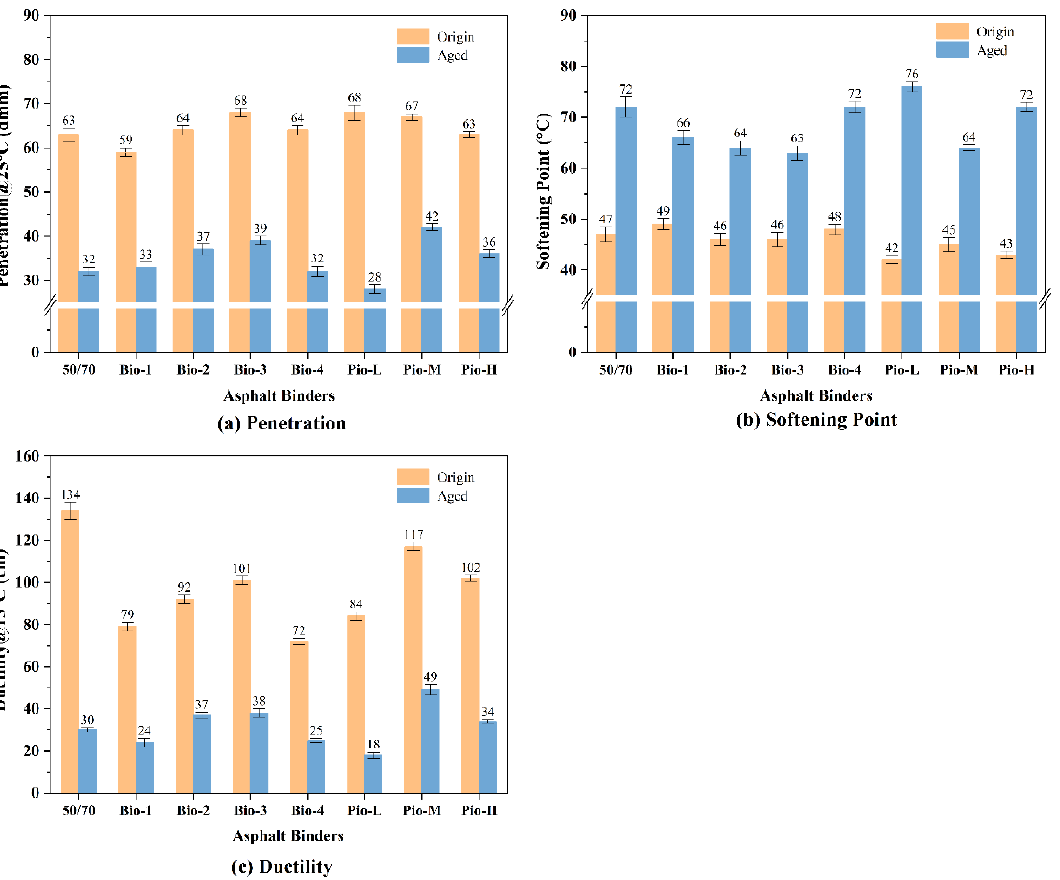
Figure 15. Basic empirical properties of all the asphalt samples: ( a ) penetration ( b ) softening point ( c ) ductility.